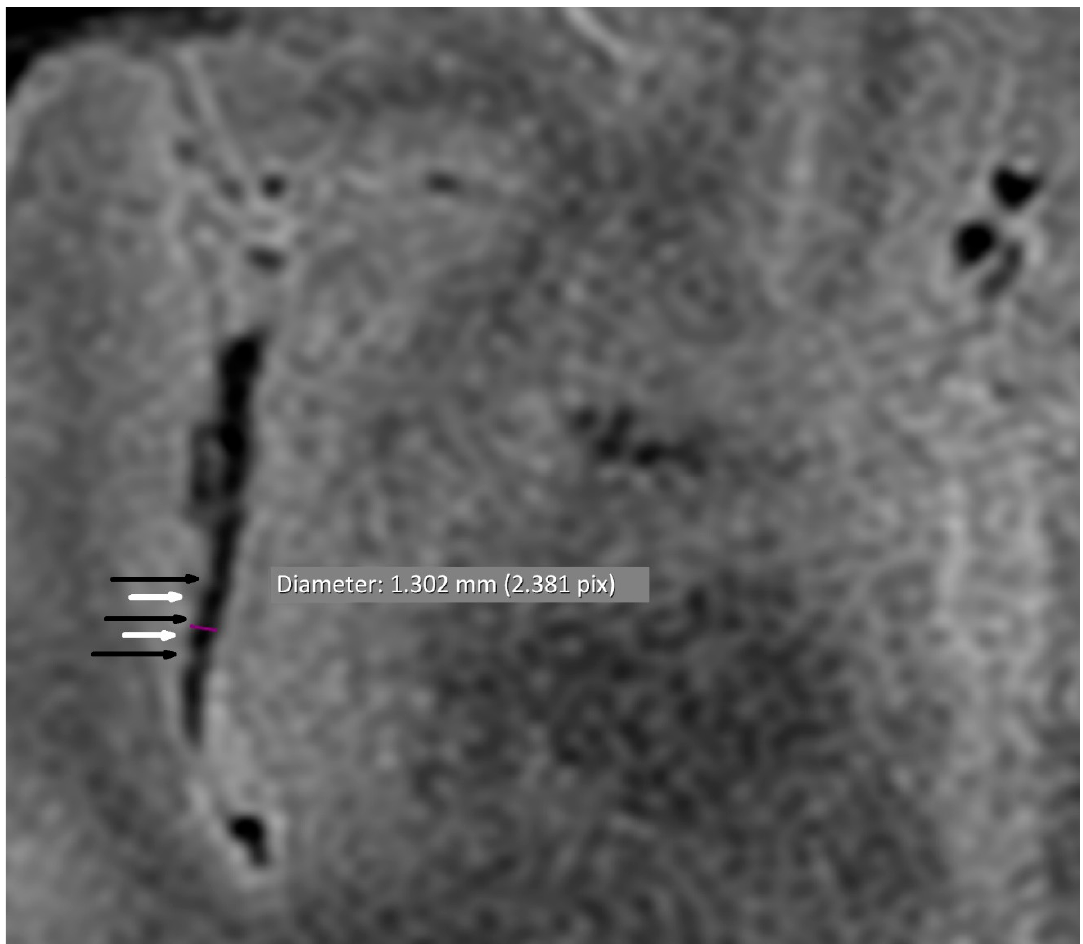
Figure 2. Alternating narrowing and dilatation in the intracranial vessel (axial plane). BB STIR T2 axial sequence; purple—diameter; black arrow—narrowing; white arrow—widening. Table 5. Correlations between alternating narrowing and dilatation in secondary and tertiary vascular branches and clinical and blood test